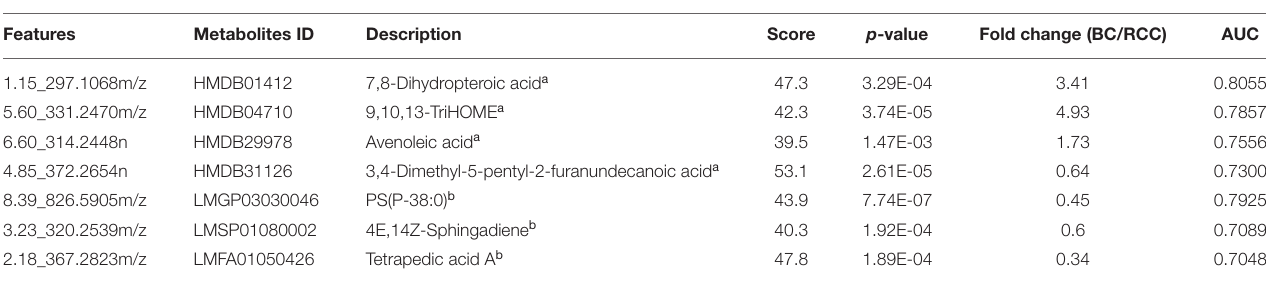
TABLE 3 | Differential metabolites for distinction of BC and